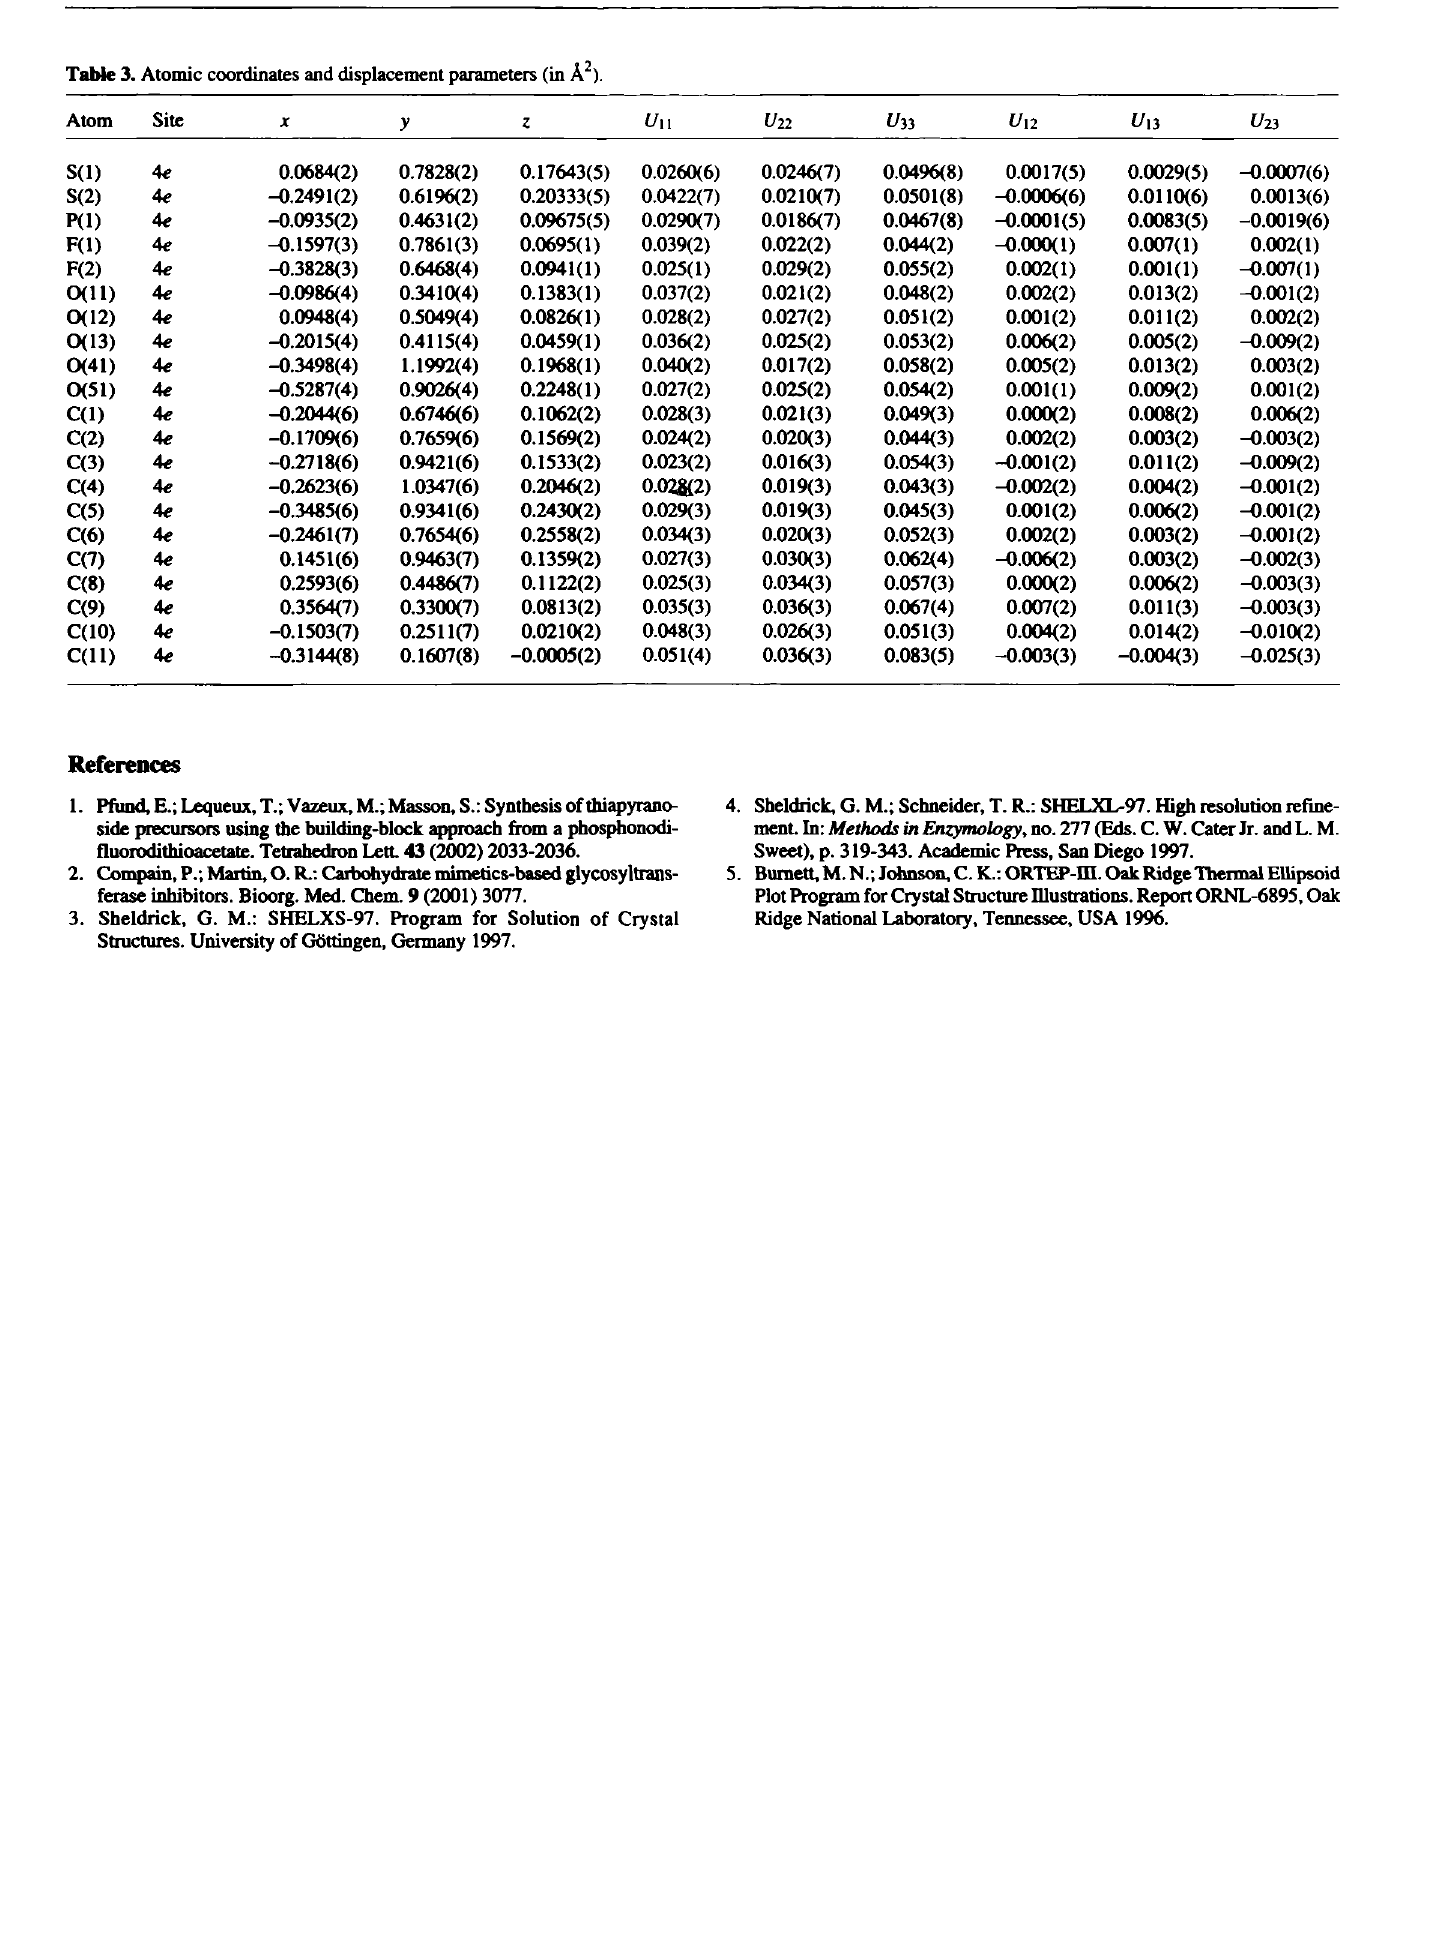
Table 3. Atomic coordinates and displacement parameters (in Ä 2